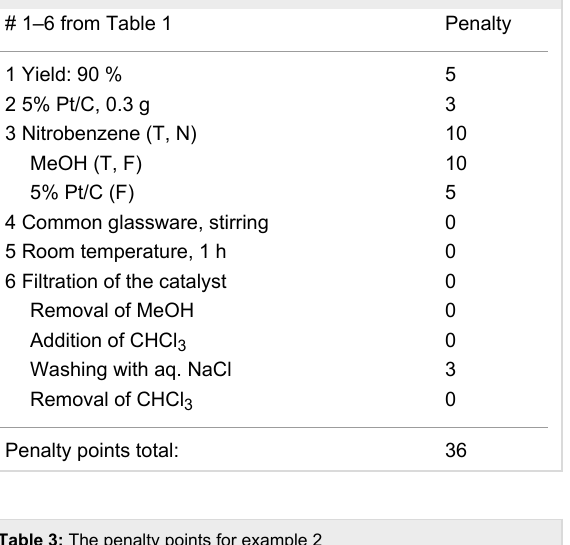
Table 3: The penalty points for example 2 # 1–6 from Table 1 Penalty